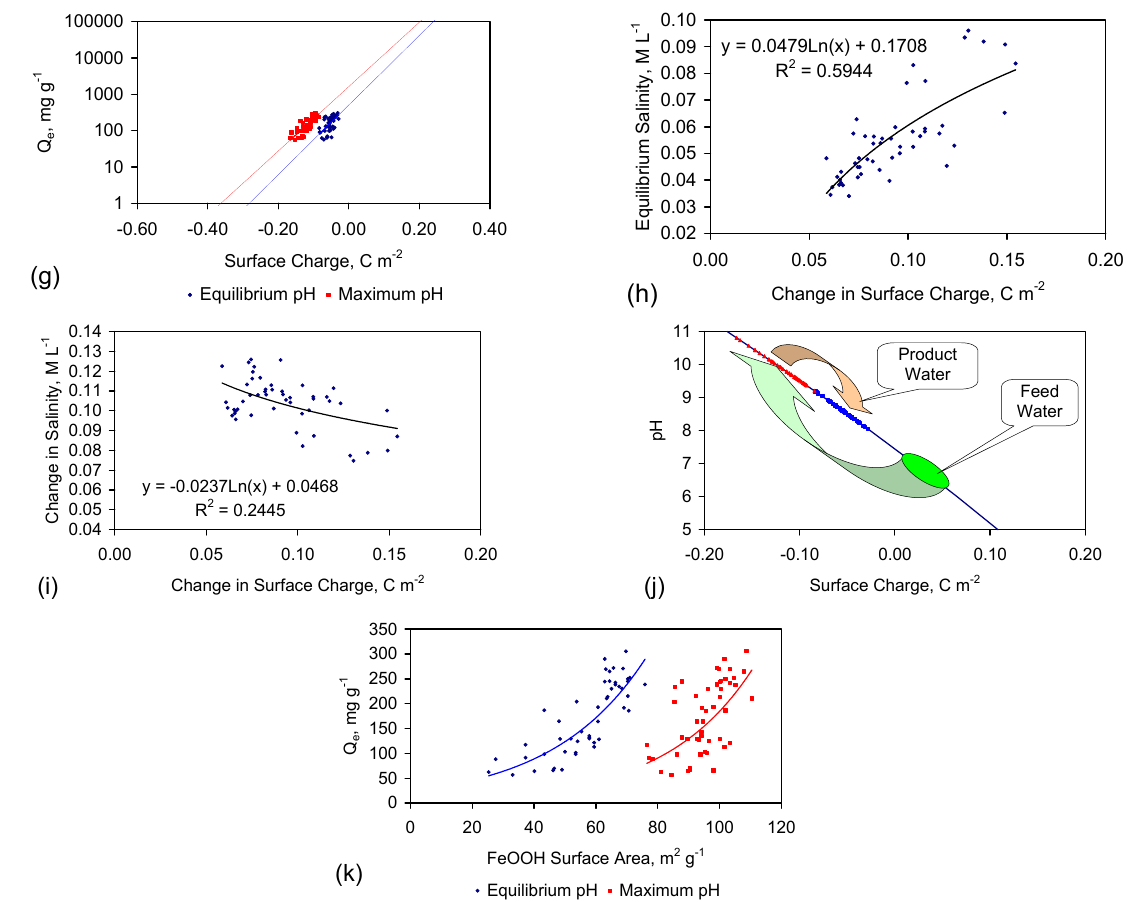
Figure 10. ZVM TP: Surface charge and Q e during desalination. ( a ) Q e (without adjustment for water consumption) vs. surface charge; ( b ) Measured relationship Q e (without adjustment for water consumption) vs. proton adsorption; ( c ) Surface charge vs. proton adsorption; ( d ) Maximum and equilibrium Eh vs. proton adsorption; ( e ) Q e (without adjustment for water consumption) vs. change in surface charge; ( f ) Measured relationship Q e (without adjustment for water consumption) vs. change in proton adsorption; ( g ) Expected Q e (without adjustment for water consumption) vs. surface charge; ( h ) Equilibrium salinity vs. change in surface; ( i ) Change in salinity vs. change in surface charge; ( j ) Desalination cycle shown by water pH vs. surface charge; ( k ) Q e vs. calculated FeOOH surface area, when ( D 1 − D 2 ) = 1. Data: